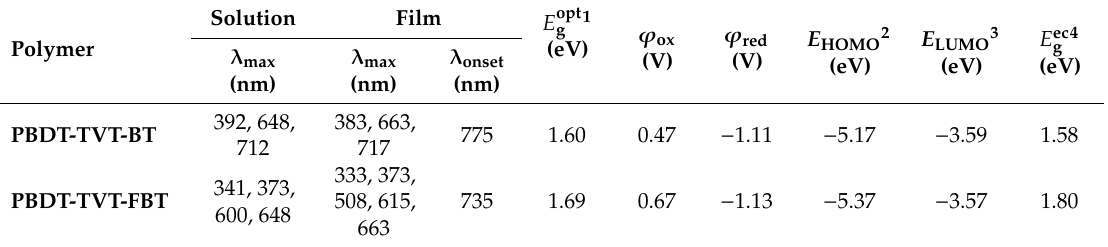
Figure 2. Normalized UV–Vis absorption spectra of the highly conjugated copolymers PBDT-TVT-BT and PBDT-TVT-FBT in diluted chlorobenzene (CB) ( a ) and thin-film state ( b ). Table 1. Optical and electrochemical properties of the studied copolymers PBDT-TVT-BT and PBDT- TVT-FBT.